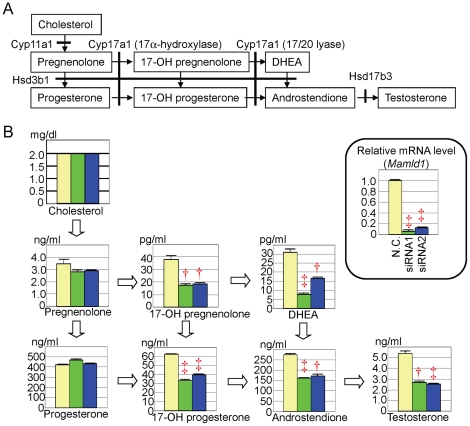
Steroid metabolite concentrations.A. Steroid metabolic pathway from cholesterol to testosterone and enzymes involved in each conversion. Pregnenolone, 17-OH pregnenolone, and DHEA (dehydroepiandrosterone) are Δ4-steroid metabolites (Δ4-pathway), and progesterone, 17-OH progesterone, and androstenedione are Δ5-steroid metabolites (Δ5-pathway). Hsd3b1 also functions as Δ5 4 isomerase. B. Steroid metabolite concentrations in culture media and endogenous Mamld1 expression levels in MLTCs. The yellow, the green, and the blue bars indicate the data obtained from MLTCs transfected with non-targeting RNA, siRNA1, and siRNA2, respectively. †: P<0.01; and ‡: P<0.001. The conversion factor to the SI unit: cholesterol 0.026 (mmol/L), pregnenolone 3.16 (nmol/L), progesterone 3.18 (nmol/L), 17-OH pregnenolone 3.00 (pmol/L), 17-OH progesterone 3.03 (nmol/L), DHEA 3.46 (pmol/L), androstenedione 3.49 (nmol/L), and testosterone 3.46 (nmol/L).